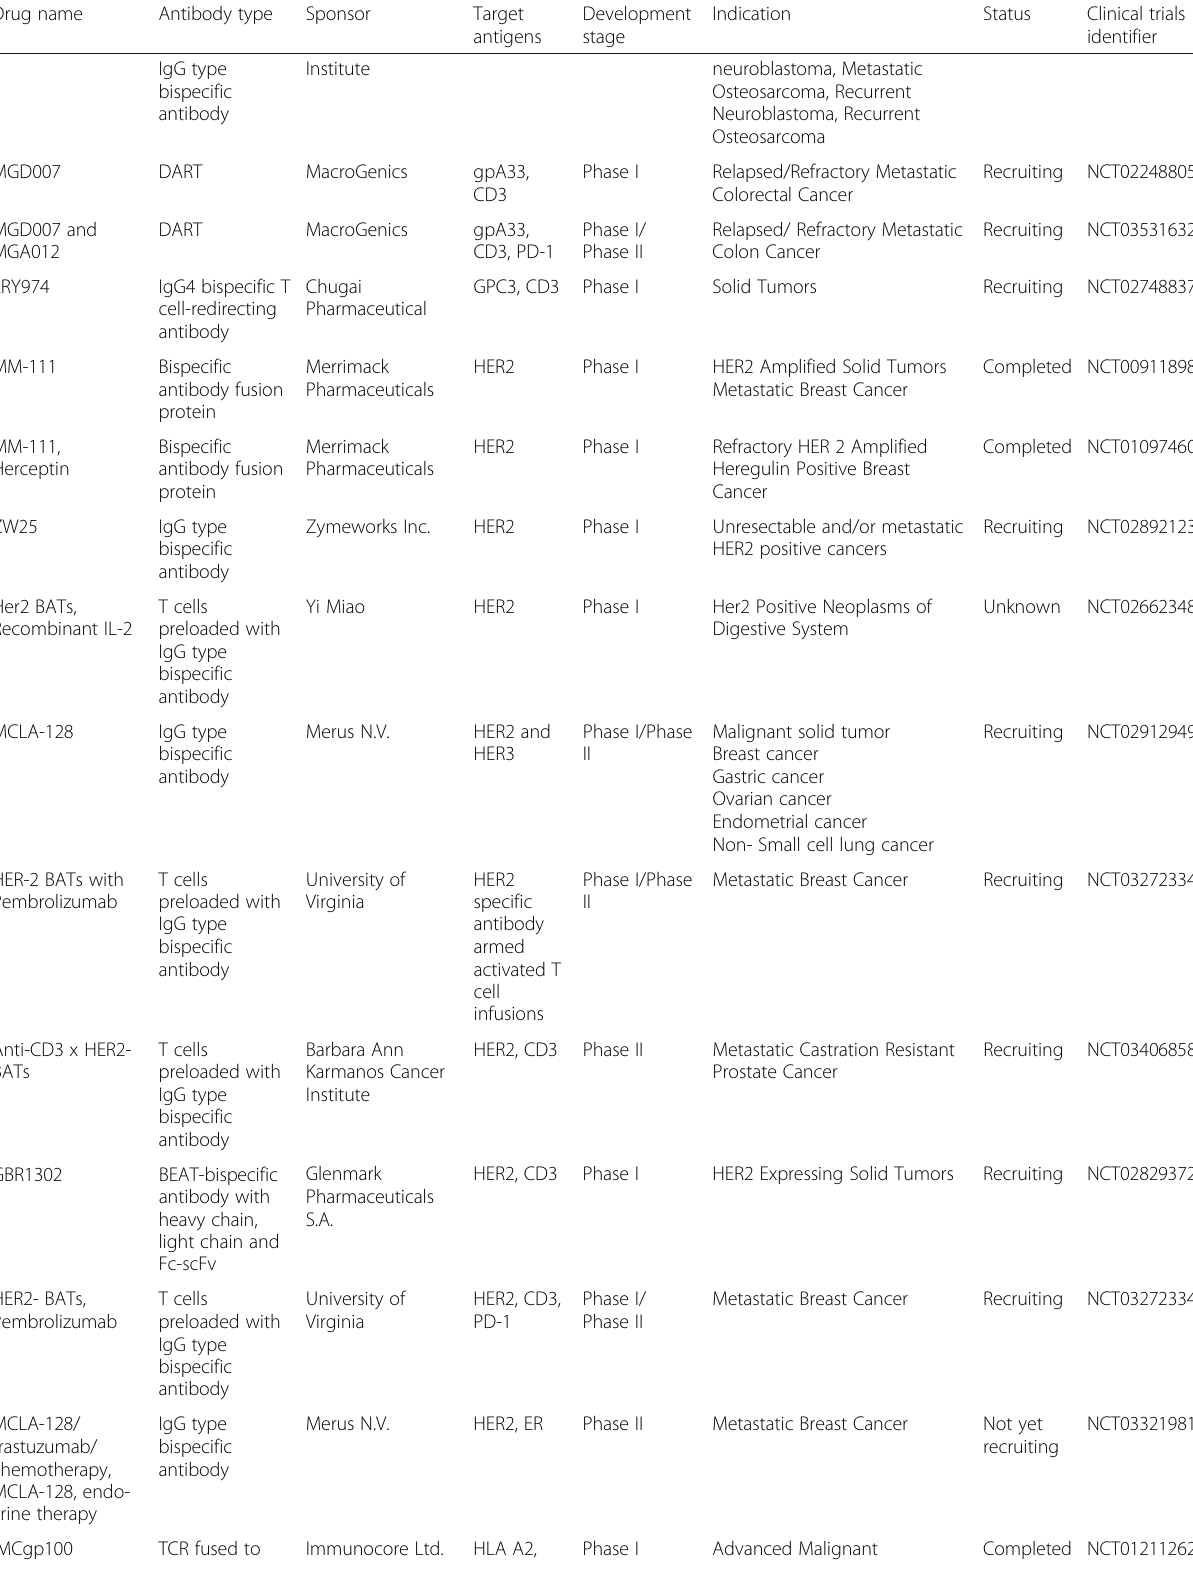
Table 4 Recent clinical trials involving the use of bispecific antibodies in solid tumor malignancies